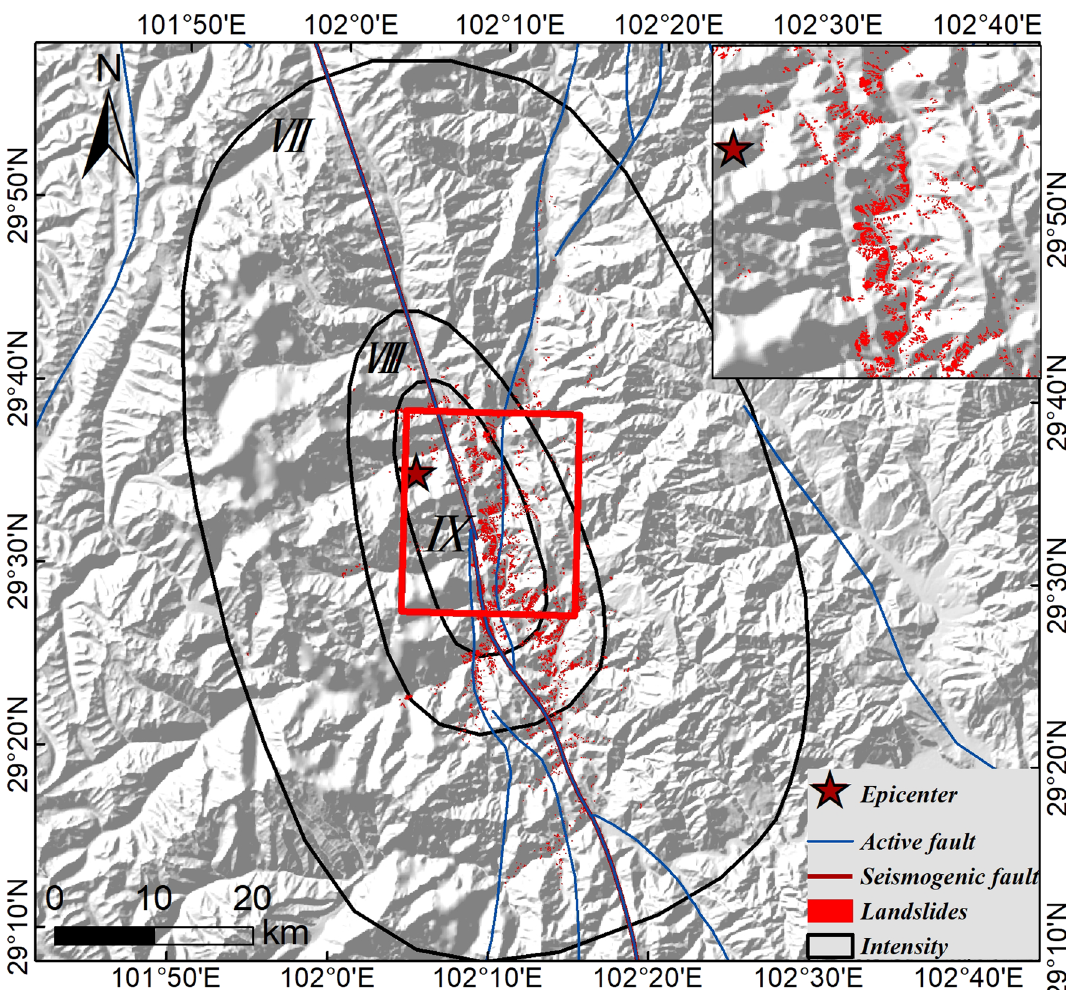
Fig. 4 Coseismic landslides distribution map, modified from Huang et al. (2022a). The black line is seismic intensity downloaded from https:// www. cenc. ac.